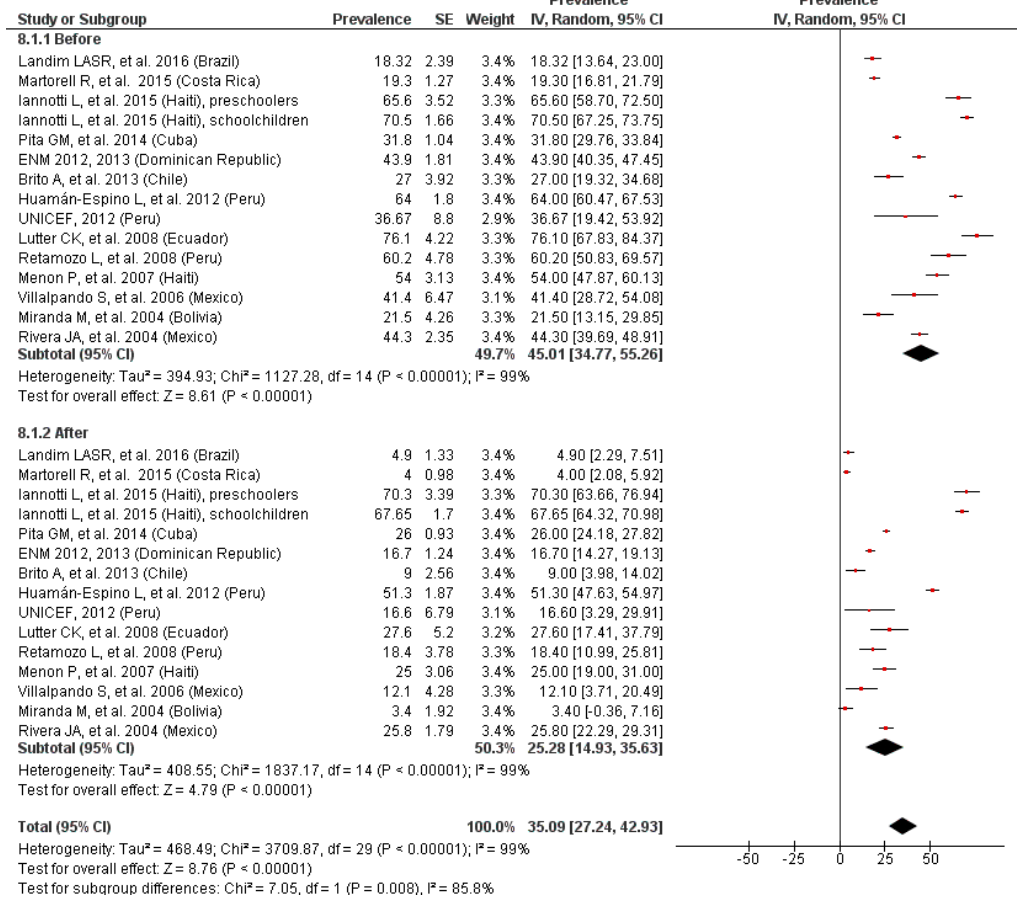
Figure 9. Effectiveness of nutritional intervention programs.